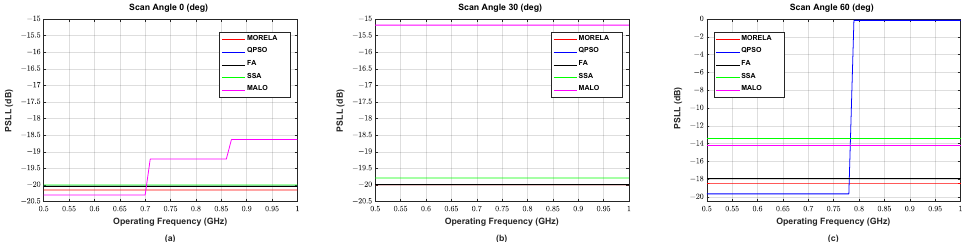
Figure 5. The SLL performance of symmetric NUSLA in case for ( a ) θ 0 = 0°, ( b ) θ 0 = 30°, and ( c ) θ 0 =